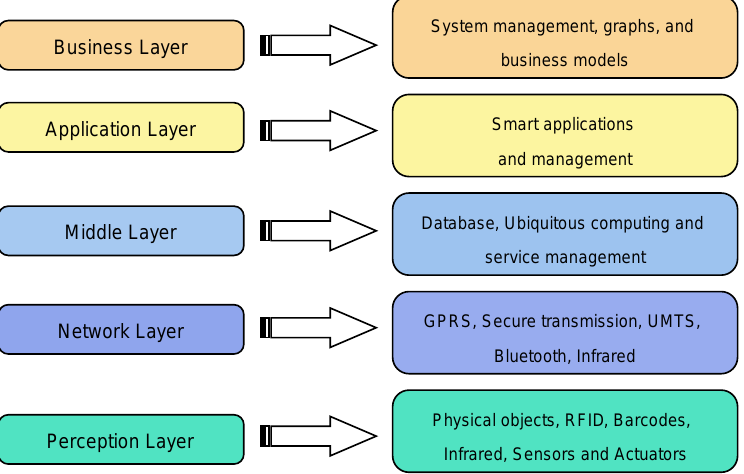
Figure 9. Five-layer model of an IoT-based